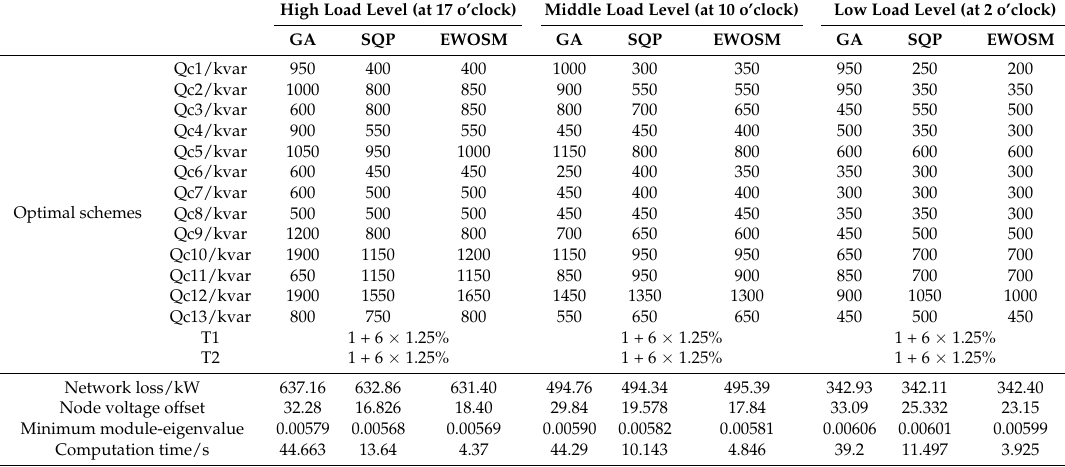
Table 4. The results of reactive power optimization with two methods under different load levels.